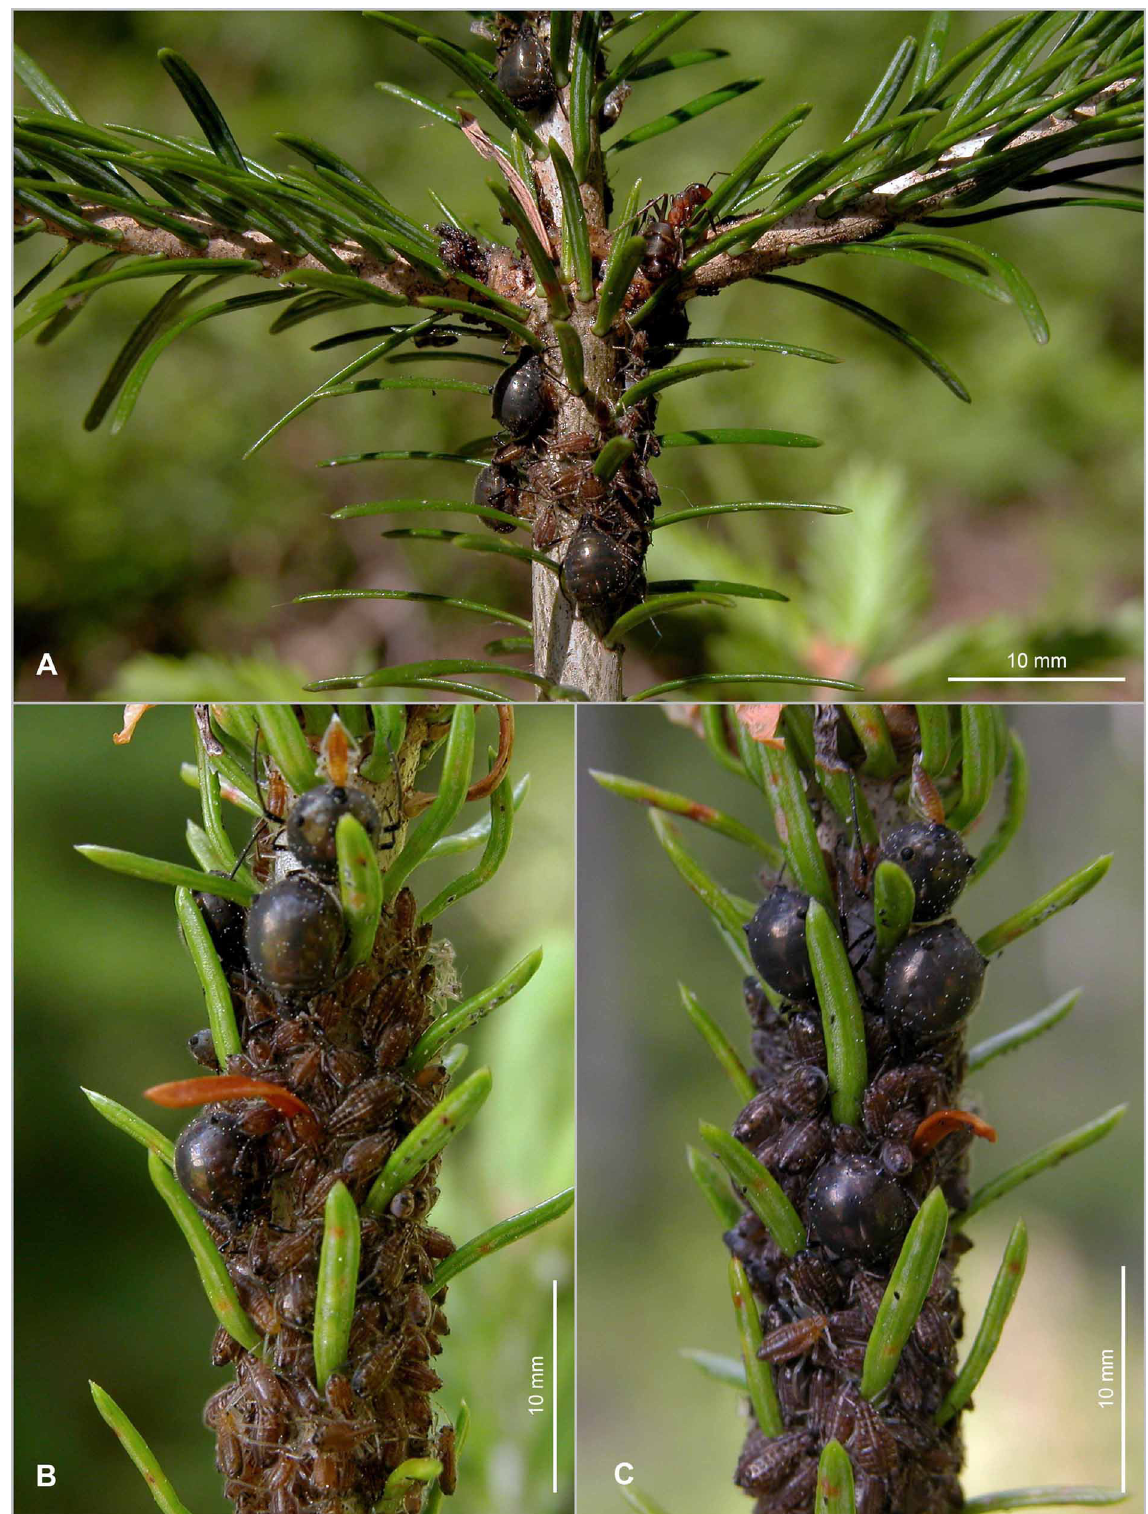
Fig. 52. Cinara (Cinara) confinis Koch, 1856 on young Abies sibirica . Colonies on 1–2 year-old parts of main shoot, attended by Formica rufa Linnaeus, 1761. B–C . Needles with brown spots and overwintered nymphs from the previous year’s infestation of Adelges (Aphrastasia) pectinatae (Cholodkovsky,